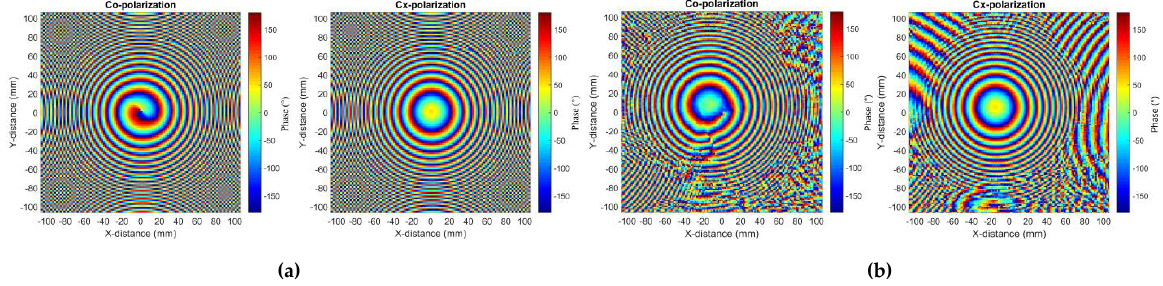
Figure 10. The near field amplitude results of the fabricated quasi-optical system with 𝜃 r = 𝜋/2 : (a) the simulated results; (b) the measured results.